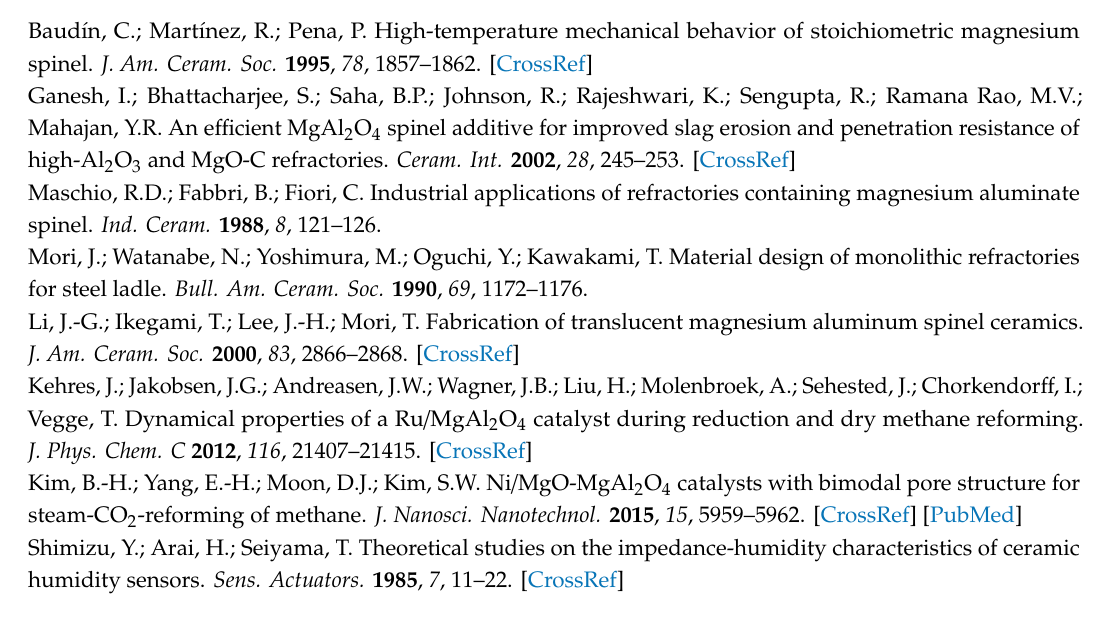
Supplementary Materials: The following is available online, Table S1: Some thermodynamic equilibrium experiments details and